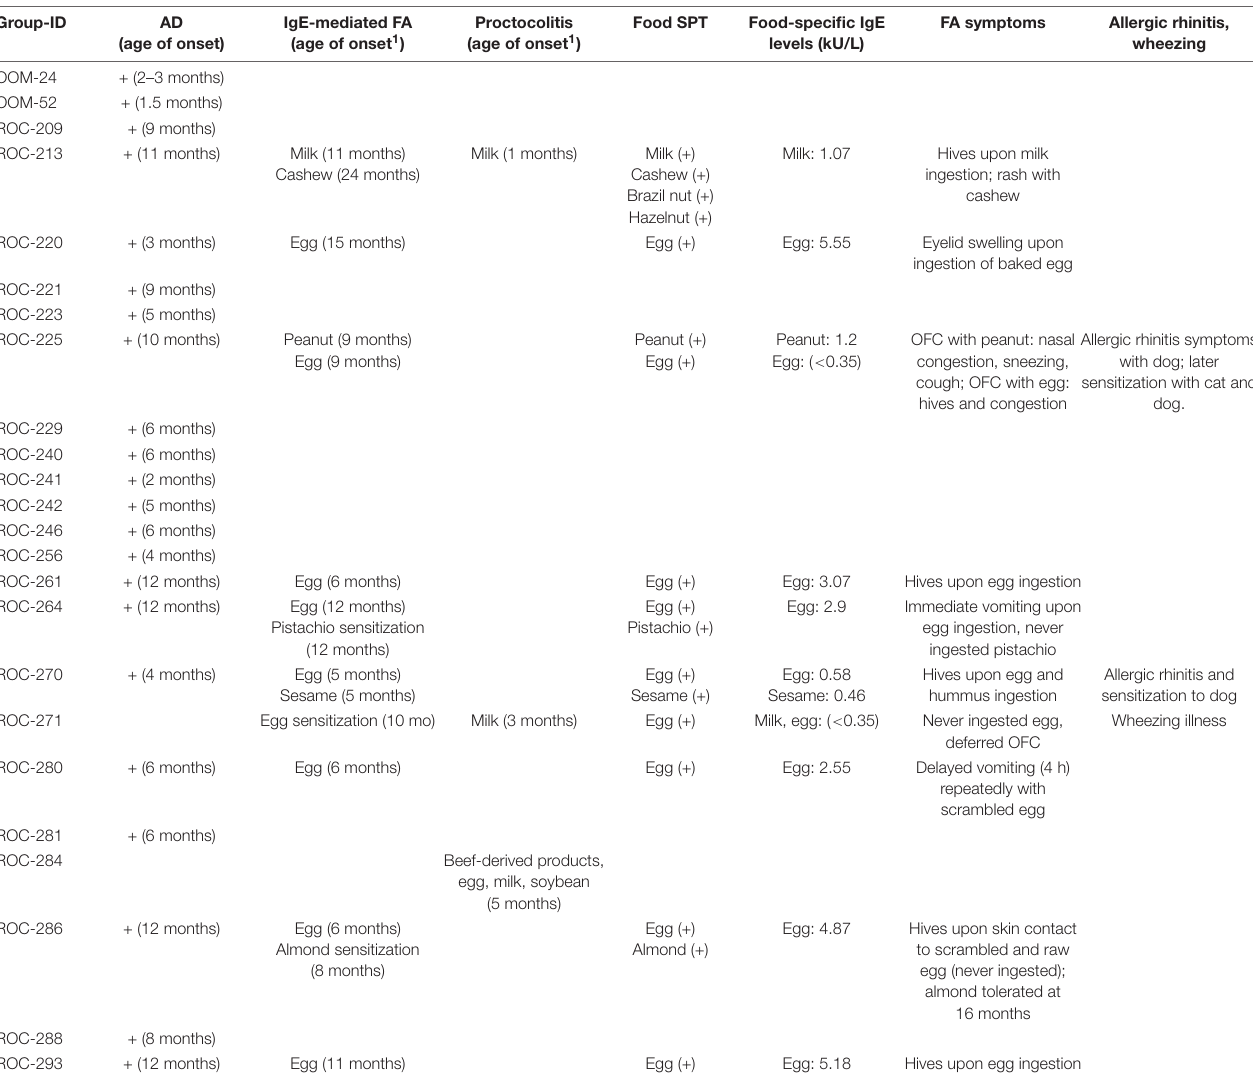
TABLE 7 | Description of atopic outcomes displayed by 12 months of